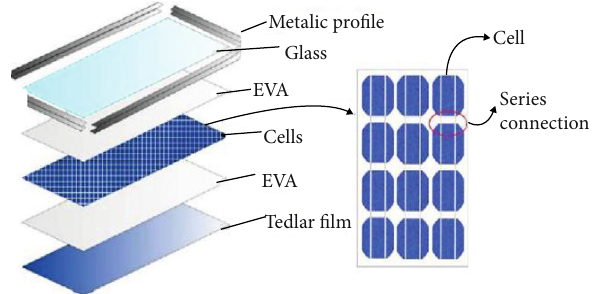
Figure 2: Components and layers of a PV module